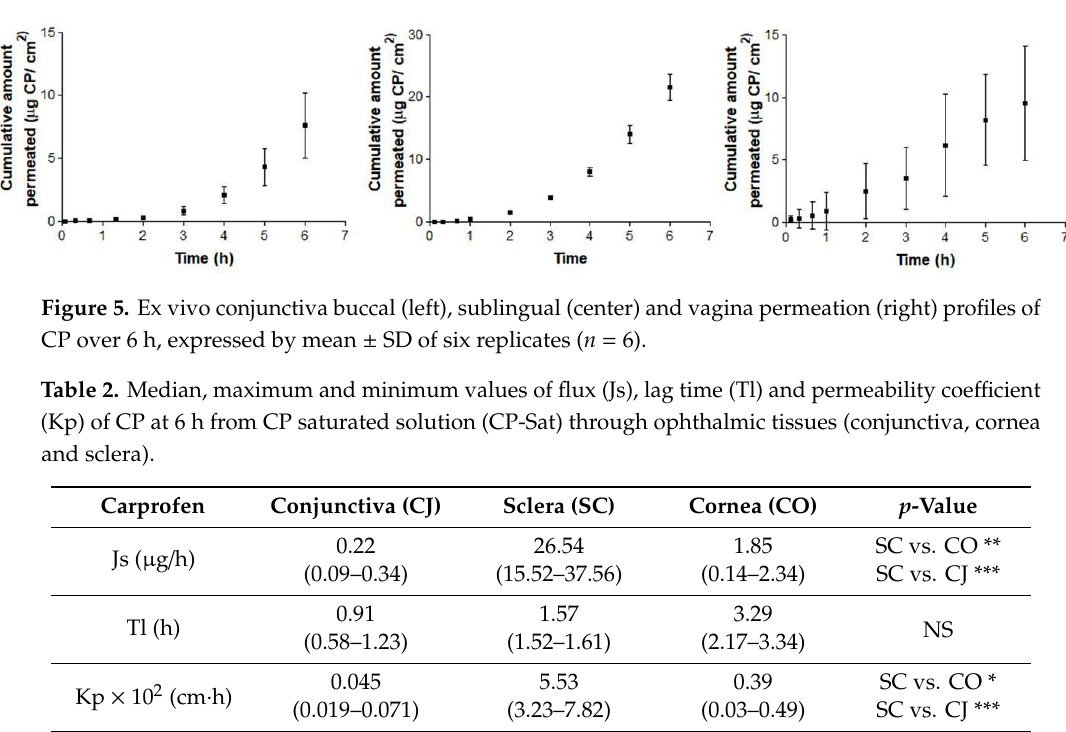
Figure 4. Ex vivo conjunctiva permeation (left), cornea (center) and scleral permeation (right) profiles of carprofen (CP) over 6 h, expressed by mean ± SD of six replicates (n = 6). Figure 5 represents permeation curves of CP through buccal, sublingual and vagina mucous membranes.